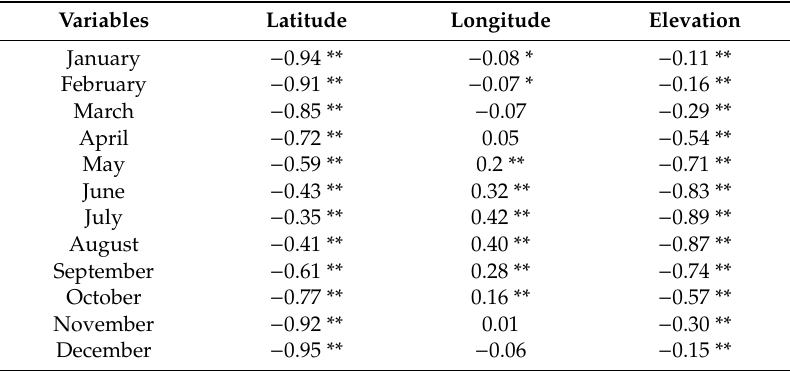
Table 2. Correlation coe ffi cients of independent variables (significance